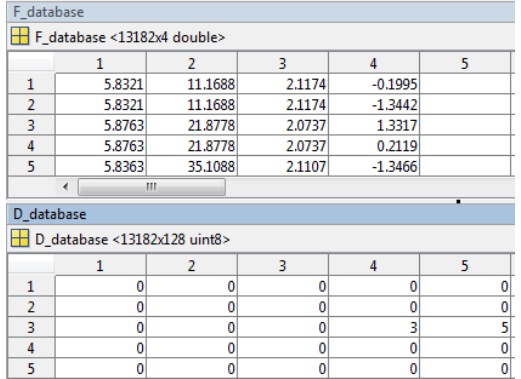
Figure 9. Reference feature database generated for the candidate image space: 13182 features from 20 reference images in the image